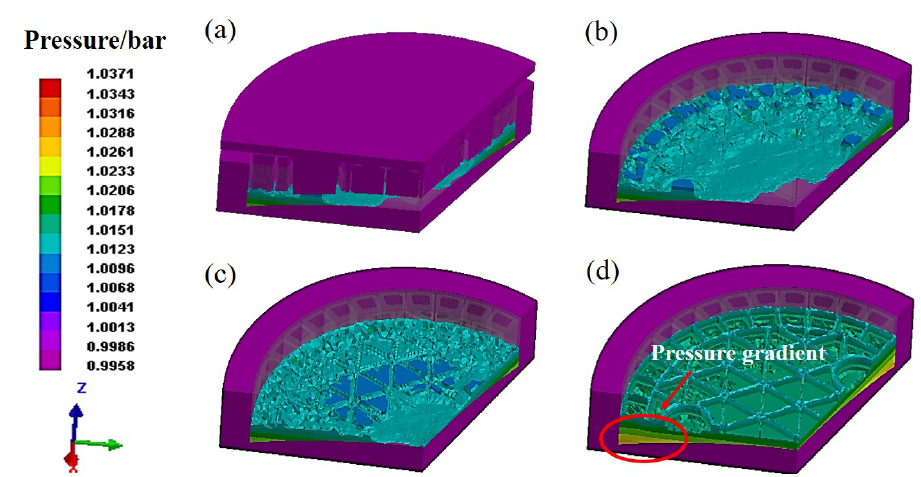
Figure 5. The pressure distribution during gel-casting process at ( a , b )19.07 s, ( c ) 31.81 s, ( d ) 34.65 s. Reducing the number of defects in the filling process is significant for the final quality of formed components. Hence, our focus is to understand the formation mechanism of various defects that seriously affects the following design and production. The porous media heat transfer model is applied to identify the temperature distribution of the green body, as the temperature contours shown in Figure 6. By comparing the surface morphology in Figure 6a,b, many obvious defects, such as cracks and pores, can be observed on the surface with the filling process. In view of the temperature contours, the generally uniform temperature distribution can be identified on the surface of body, as well as the cross sections. Accordingly, the formation of defects is rarely dependent on the temperature gradients in the body. Given the complex geometrical model, nevertheless, the capillary effect exists consequentially owing to the irregular-shaped upper die. Since the flow behavior of the slurry continues, gas appears even though the upper die stops pressing down. Then, a large amount of gas trapping probably occurs and remains on the surface of the green body. To discuss this in depth, Figure 7 plots the pressure distribution in the filling process. The lower pressure can be observed on the surface of green body as well as the edge of vertical ribs, which is probably related to the gas trapping. The gas in the slurry moves constantly with the varying pressure, inevitably resulting in the various defects on the forming structure after the filling process.